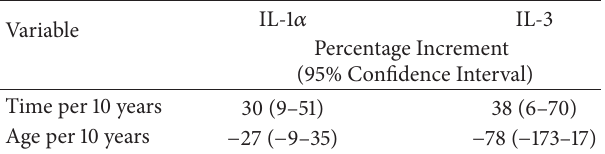
Table 3: Multivariate models of the effects of underground time and age on IL-1 𝛼 and IL-3